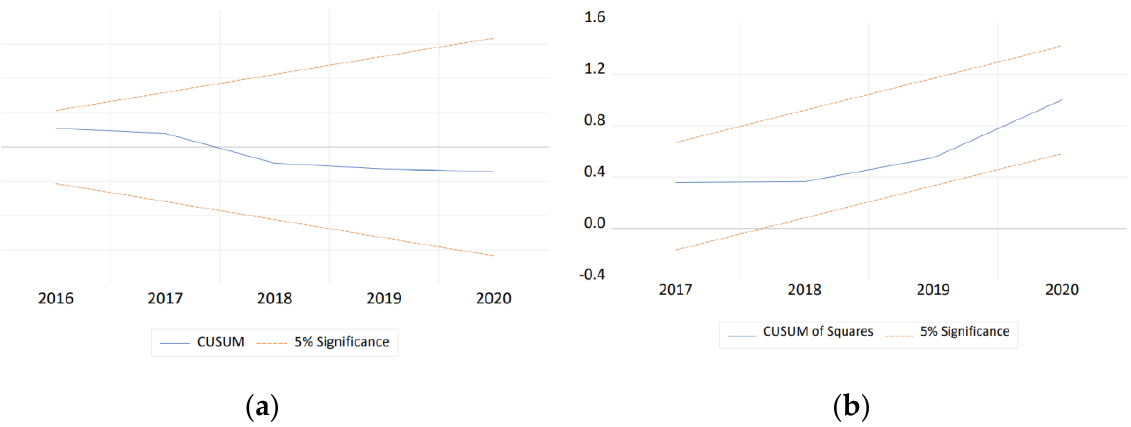
Figure 4. ( a ) Testing the stability of the model with the CUSUM test; and ( b ) testing the stability of the model with the CUSUMsq test.